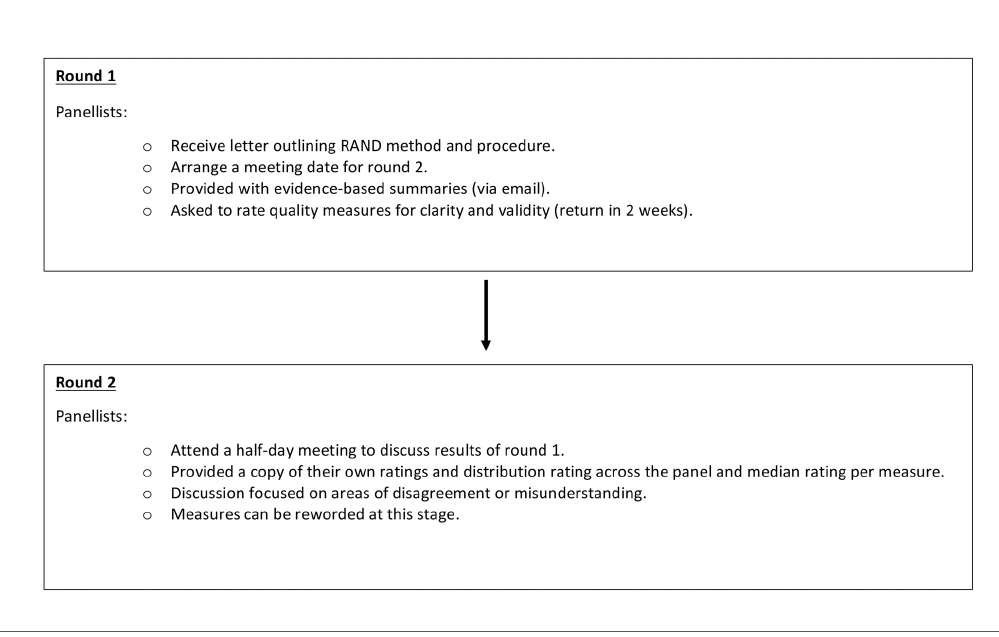
Figure 1. RAND consensus methodology process for